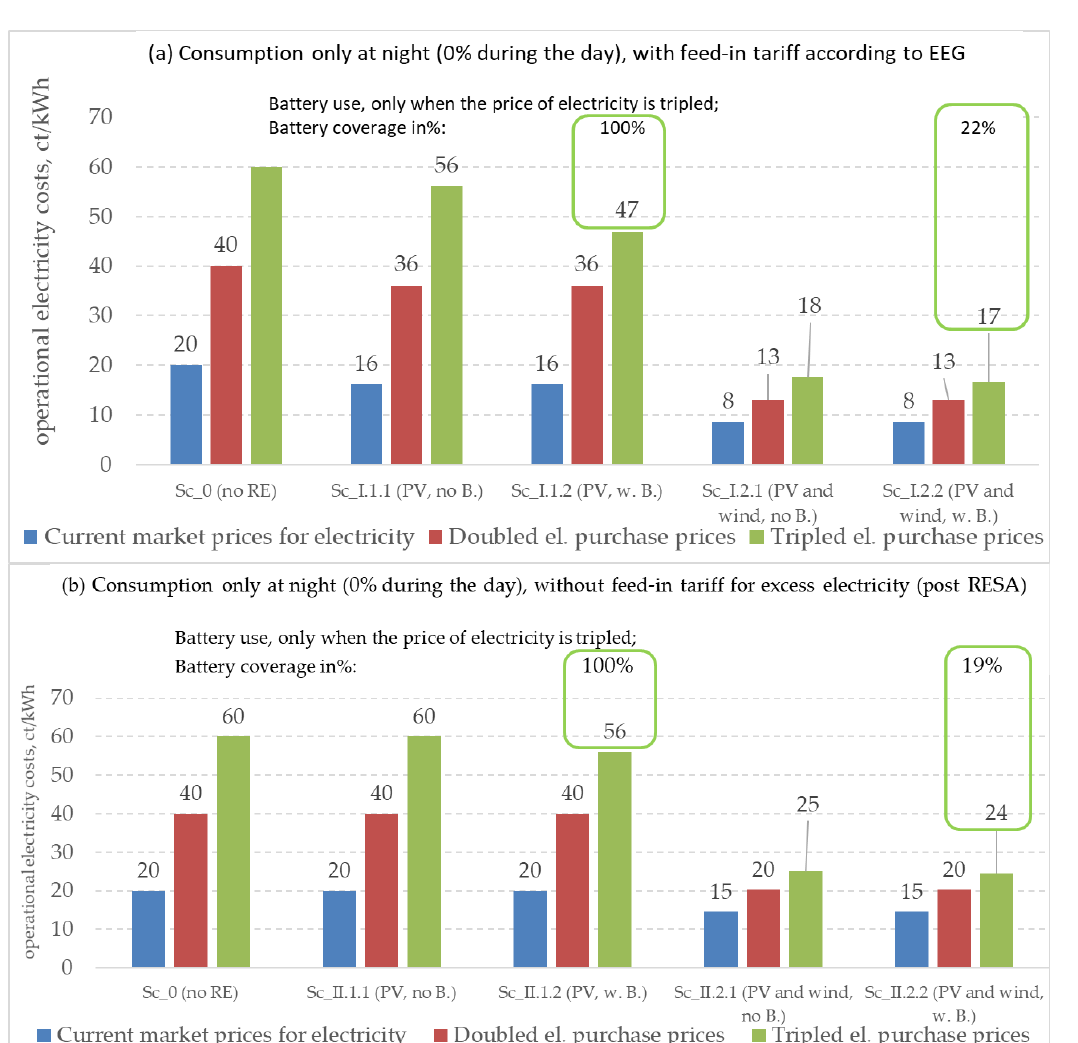
Figure 8. Cost of electricity for a farm with consumption only during the day (100% day) for status quo (0.20 ct/kWh) and when price is doubled or tripled, as well as investments in PV or PV and wind, showing batteries are not worth the in- vestment: ( a ) Sc_I: with feed-in tariff according to RES Act (PV power 13 ct/kWh or wind power 5 ct/kWh) ( b ) Sc_II: without feed-in tariff for excess electricity (post-RESA).